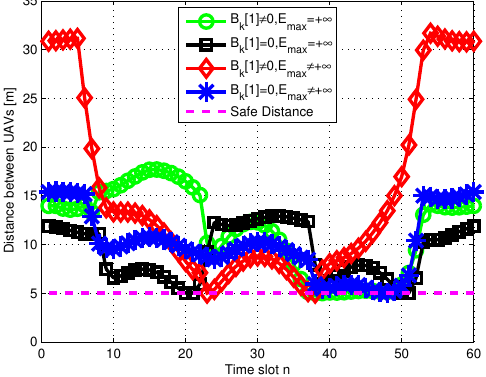
Figure 7. Distance between UAVs when T = 60 s.